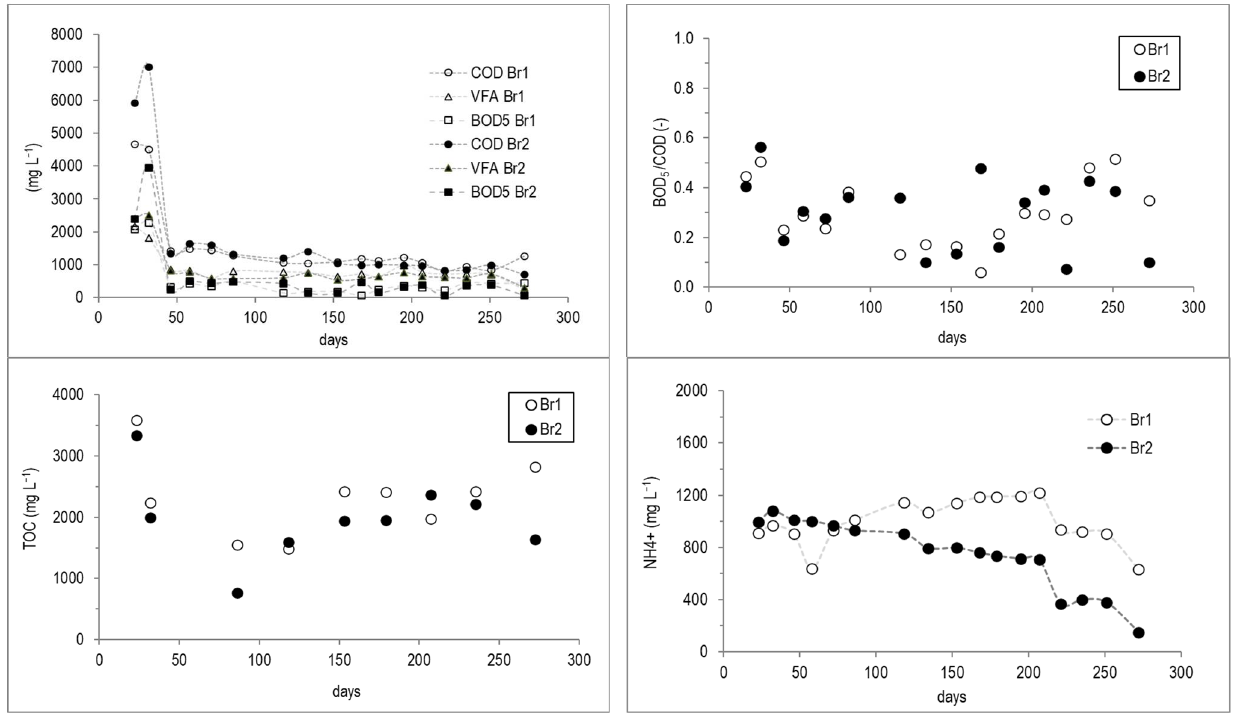
Figure 2. Evolution of leachate physicochemical parameters during experiments in bioreactors.